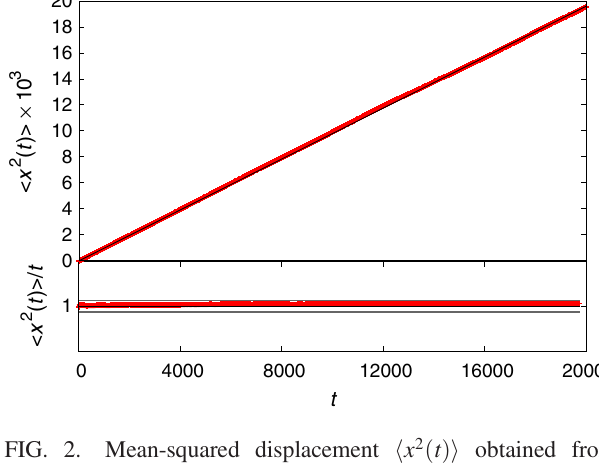
FIG. 2. Mean-squared displacement h x 2 ð t Þi obtained from simulation of the set of Langevin equations (20a) – (20c) at d ¼ n ¼ 1 , corresponding to the red symbols (because of the density of points, these appear as the thick red line), showing excellent agreement with the Brownian law (1) shown by the (thin) full black line. In the bottom panel, we show h x 2 ð t Þi =t , demonstrating that the deviations from the expected behavior are fairly small. The grey lines (lower panel) show an interval [0.975, 1.024] around unity, based on 10 6